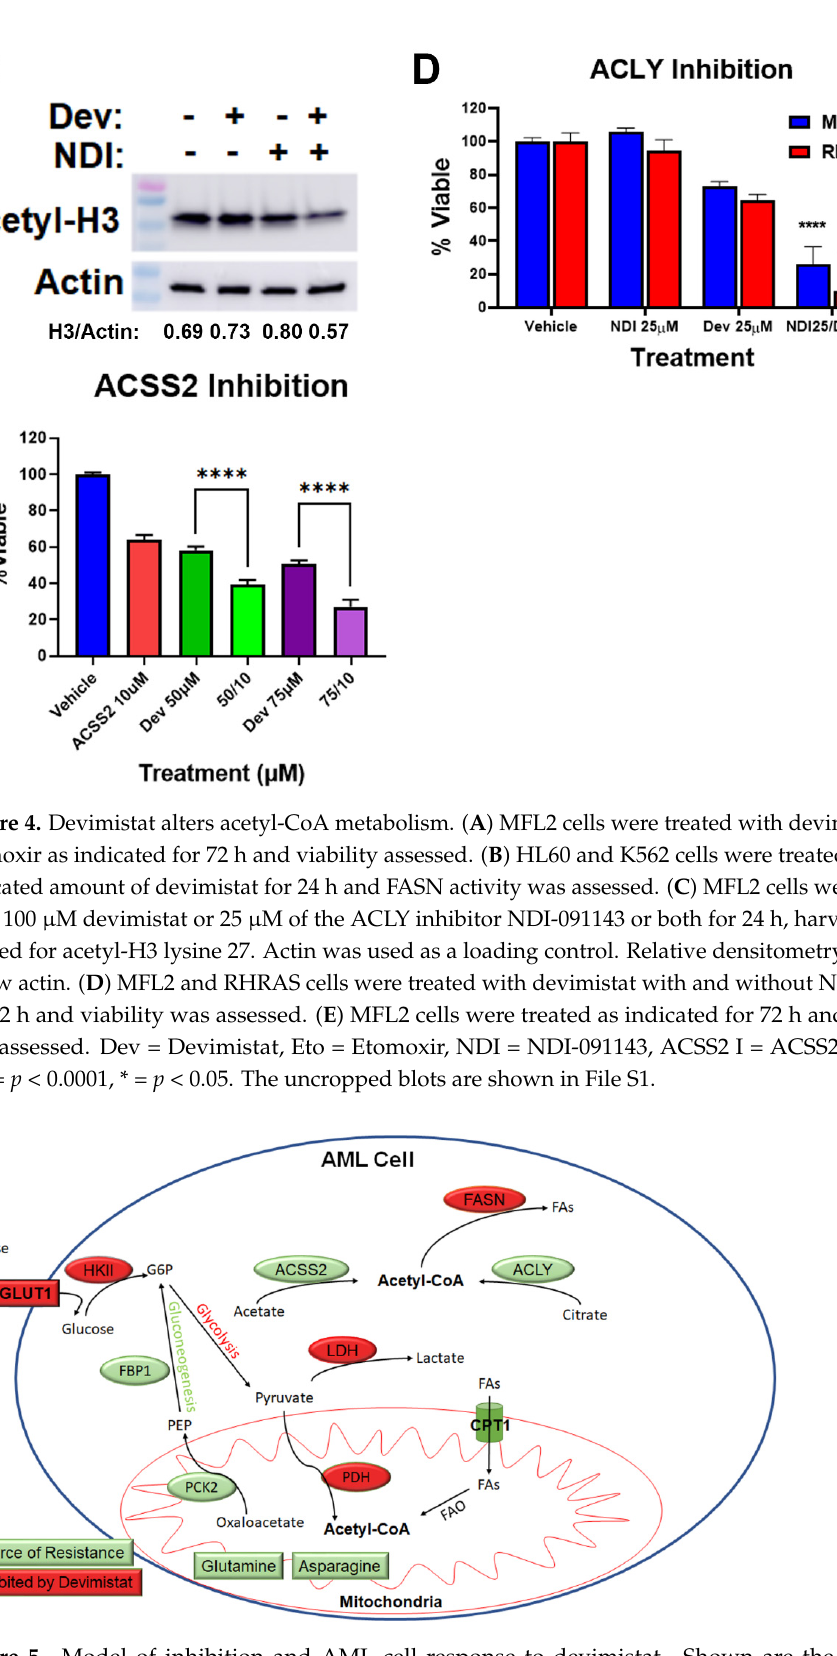
Figure 5. Model of inhibition and AML cell response to devimistat. Shown are the enzymes, metab- olites and pathways that are sources of resistance (green) or inhibited by devimistat (red). FAs = fatty acids, FAO = fatty acid oxidation, G6P = glucose-6-phosphate.